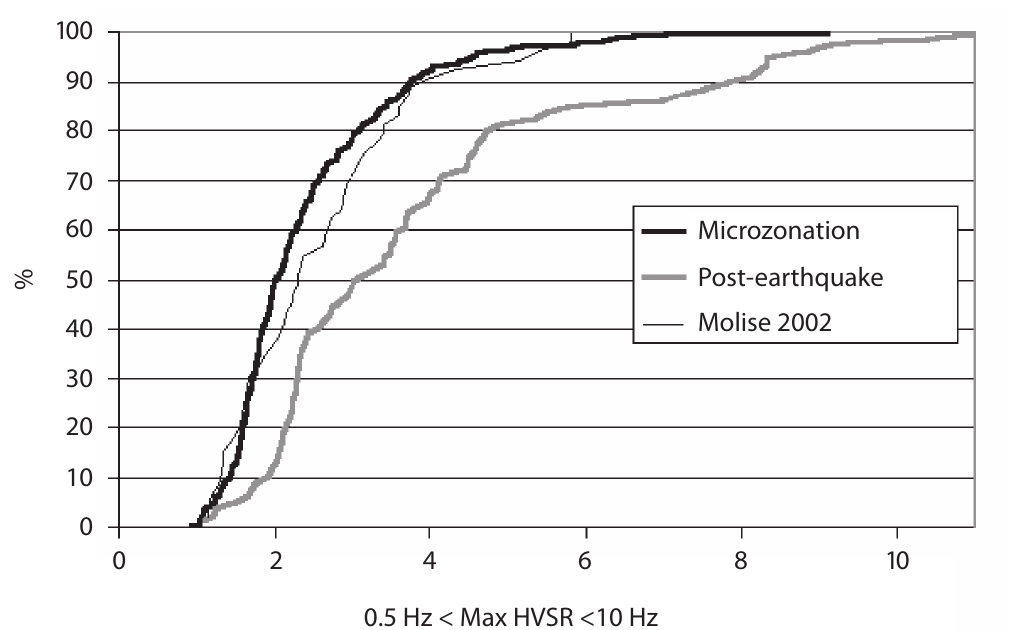
Fig. 1. Comparison between the empirical cumulative distribution functions of different sets of HVSRs, as a function of the largest value observed in the frequency range 0.5-10 Hz. See text for